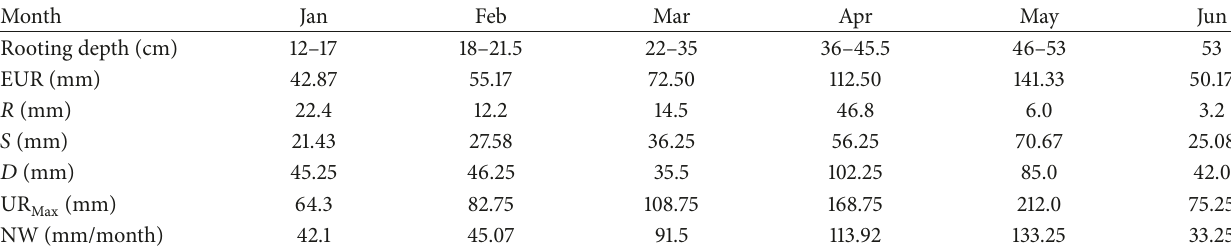
Table 2: Summary of monthly results during the development cycle (January–June).